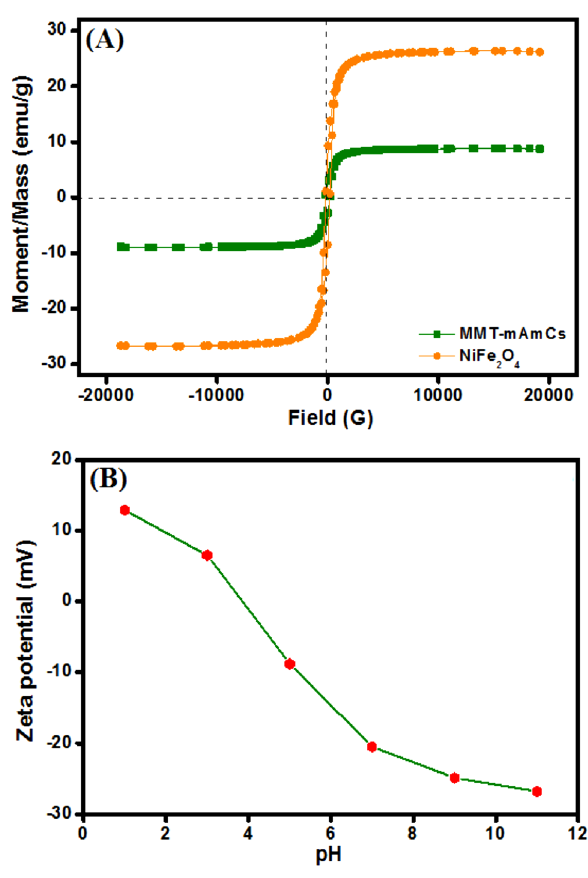
Figure 2. ( A ) VSM of NiFe 2 O 4 and MMT-mAmCs composite and ( B ) ZP measurements of MMT-mAmCs